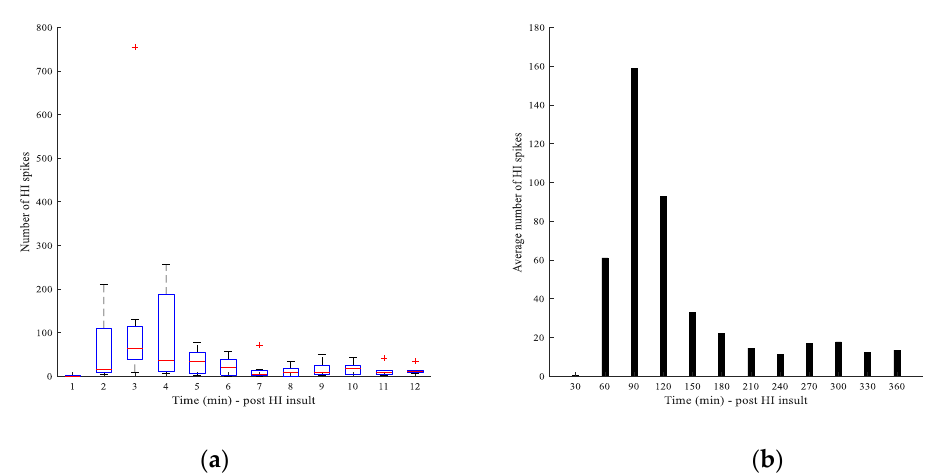
Figure 6. ( a ) Boxplot of the TP hits by the FFT-Type-1-FLC classifier in 30-min epochs within the latent phase, post-HI insult. ( b ) Average number of TP hits by the proposed classifier in 30-min epochs within the latent phase, post-HI insult.